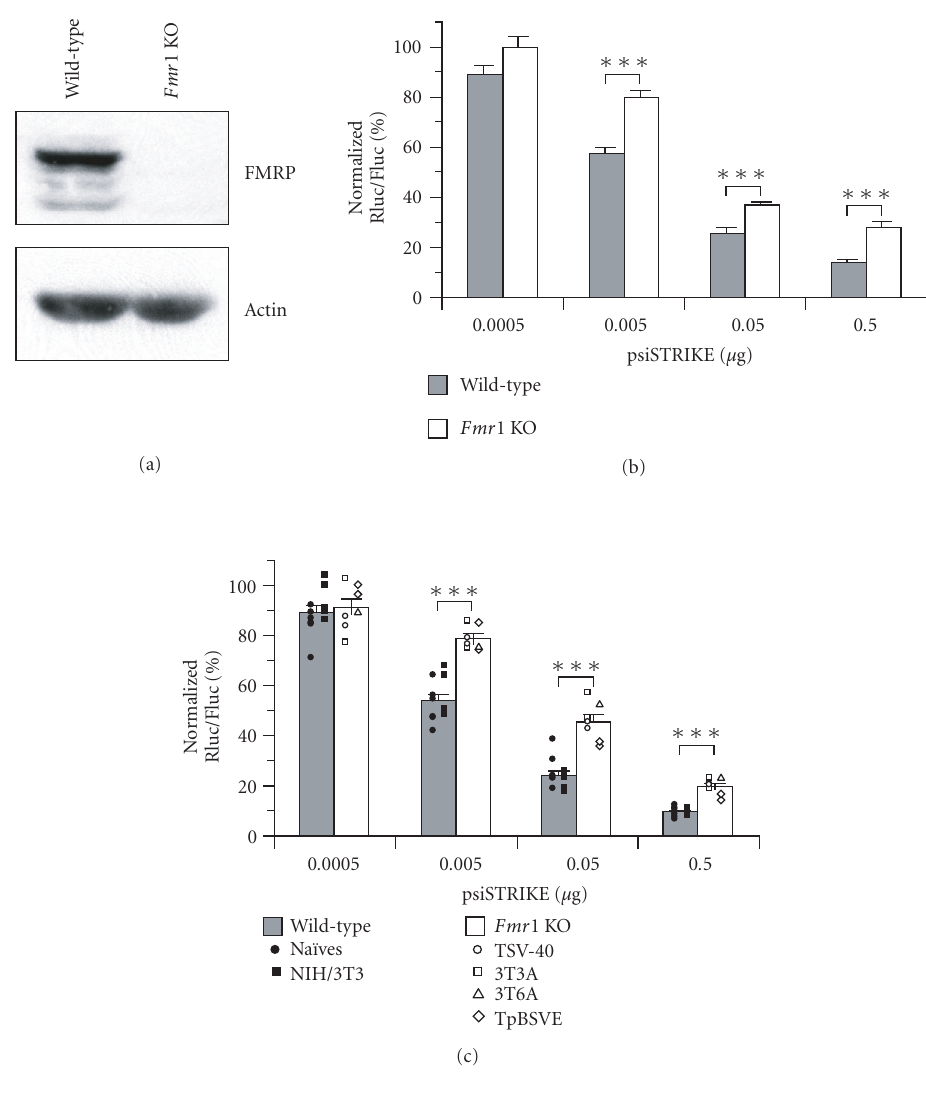
Figure 4: FMRP is required for e ffi cient RNA silencing in mammalian cells. (a) Expression of FMRP in wild-type and Fmr1 KO (TSV-40) cells was verified by immunoblot analysis, in parallel with actin. (b) Fmr1 KO (TSV-40) and wild-type (Na ¨ ıves) cells were cotransfected with psiSTRIKE encoding Rluc shRNA and psiCHECK reporter construct ( n = 6). (c) Fmr1 KO cell lines STEK TSV-40 ( n = 2), STEK 3T3A ( n = 2), STEK 3T6A ( n = 1), and STEK TpBSVE ( n = 2), and wild-type Na¨ıves ( n = 6) and NIH/3T3 ( n = 5) cell lines were cotransfected as in (b). Results of Rluc activity were normalized with Fluc activity and expressed as a percentage of Rluc activity obtained with an shRNA directed against a sequence deleted in the Rluc reporter mRNA. Results were expressed as mean ± SEM and analyzed by analysis of variance followed by unpaired Student’s t test. ∗∗∗ P < .